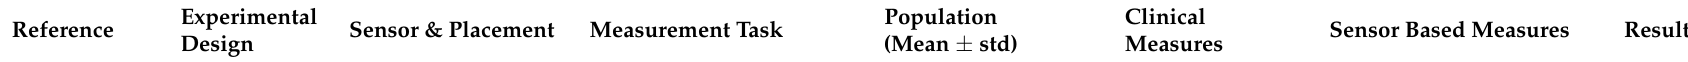
Table A2. Continuous recording during Activities of Daily Living